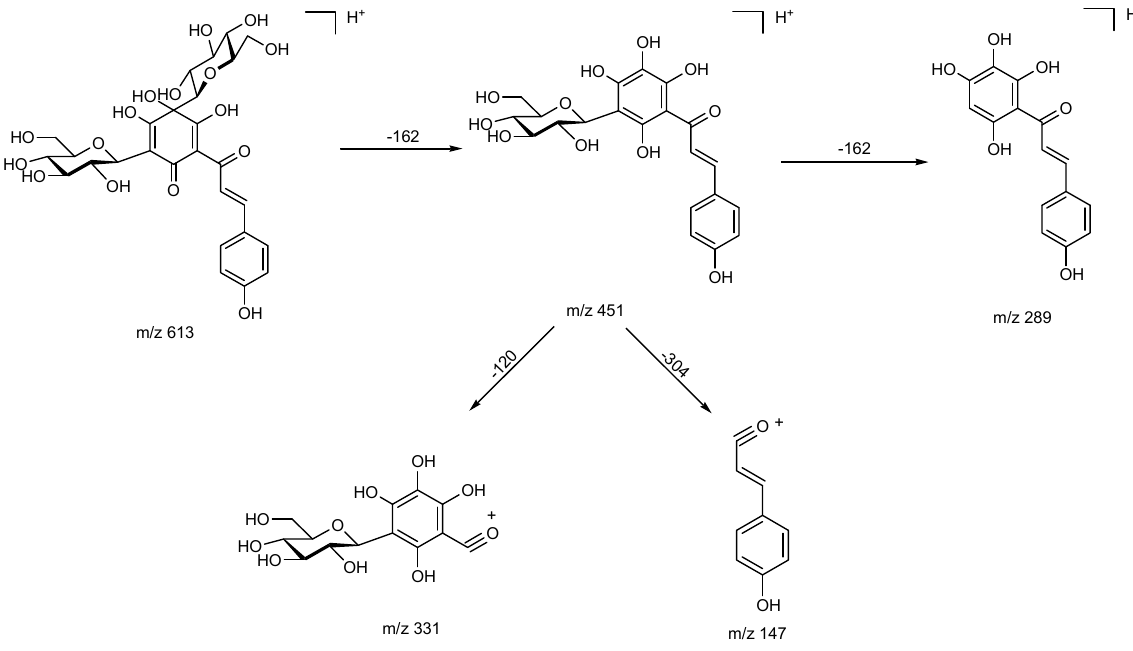
Figure 3. Common fragmentations proposed for quinochalcone C -glycosides in positive ion mode.